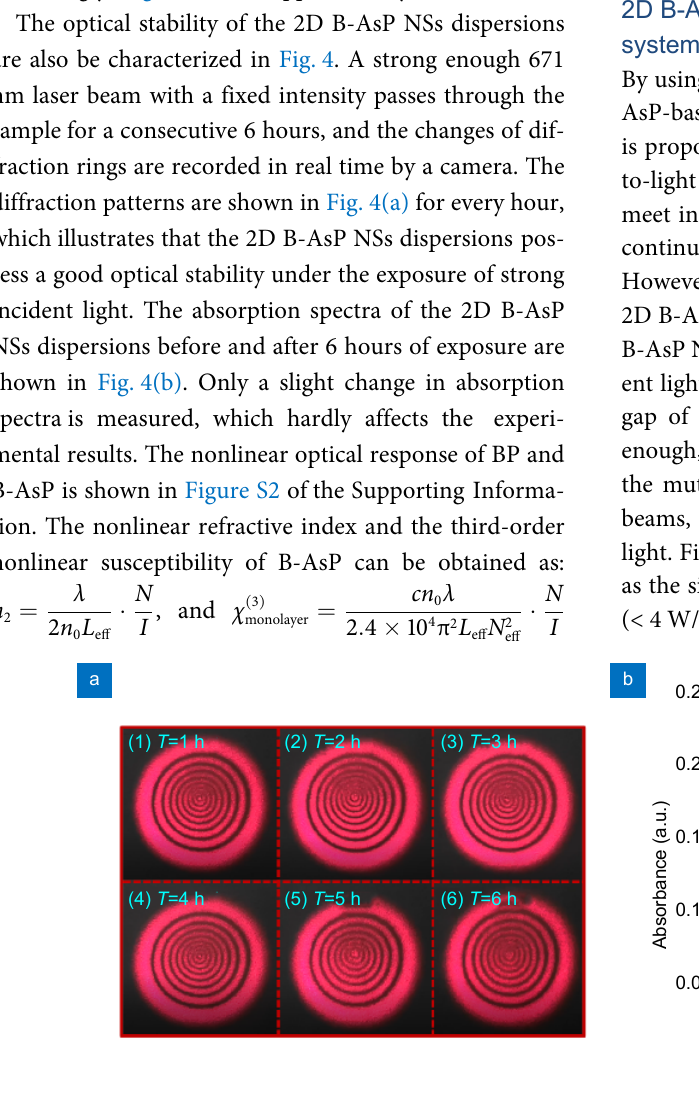
Fig. 4 | ( a ) The diffraction patterns excited from the 2D B-AsP NSs dispersions with a high light intensity for consecutive 6 hours. ( b ) The absorp- tion spectrums for the 2D B-AsP NSs dispersions before and after 6 hours of